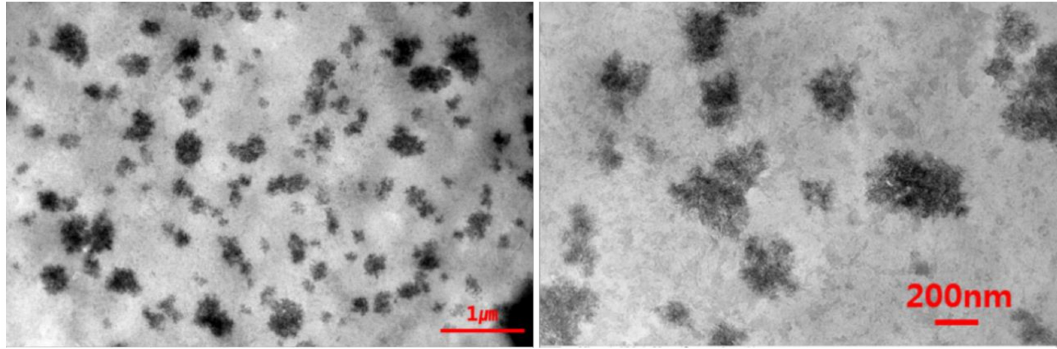
Figure 1. TEM micrographs of spherical RCNs prepared by hydrolyzing microcrystalline cellulose (MCC) with a NaOH-based aqueous solution.